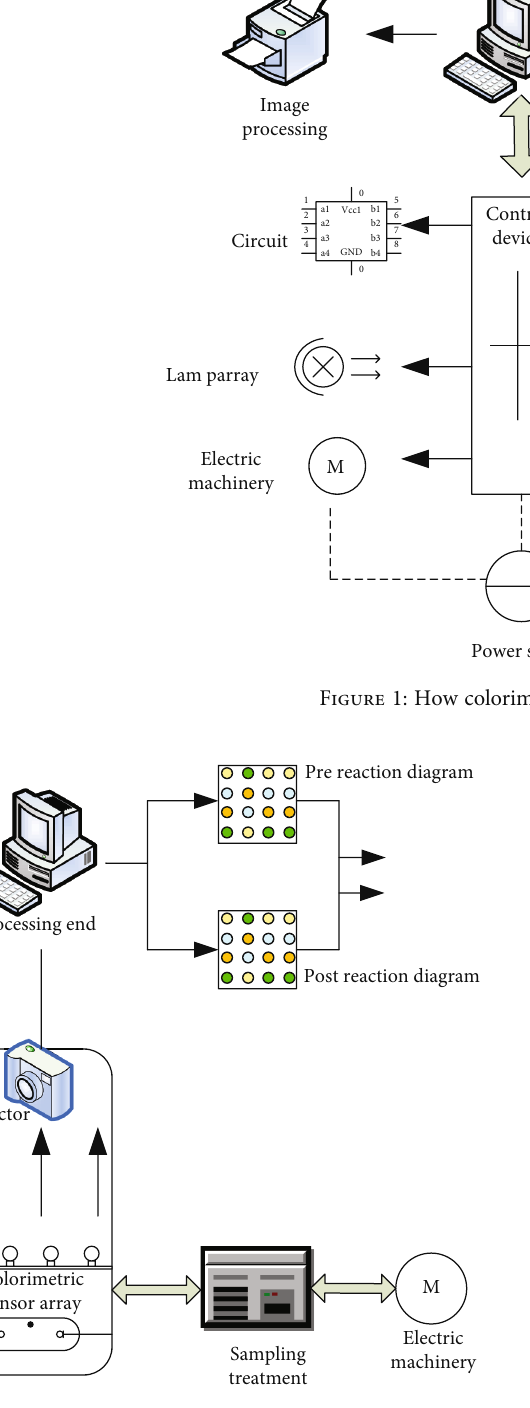
Figure 2: Colorimetric sensor working